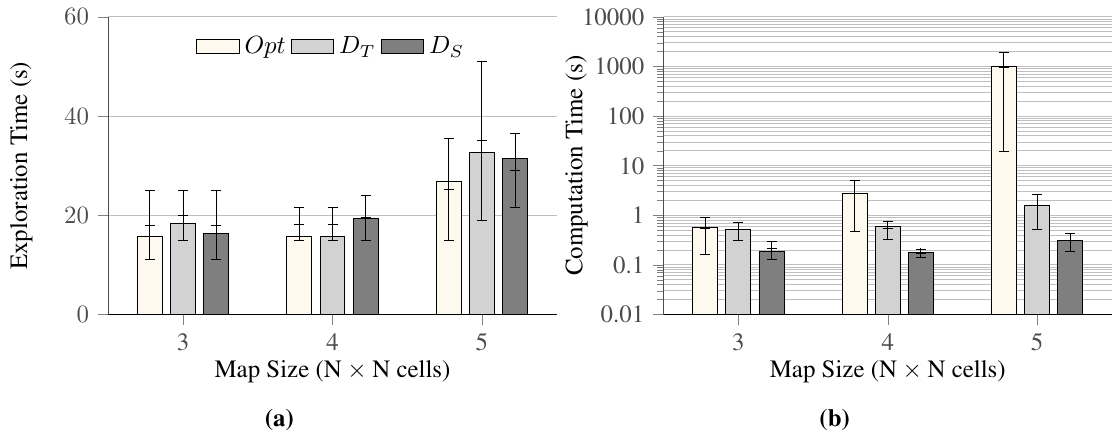
Figure 6. Comparison of all approaches, optimal and disjoint ( Opt , D of maps. Each set contains maps of varying size, from 3 × 3 to 5 × 5. The solid bars indicate the average values over the 3 maps for 3 × 3 and 10 maps for the rest, and error bars show the minimum and maximum values observed during the trial. ( a ) shows the solution quality; and ( b ) shows the computation time taken by the all three approaches on a logarithmic